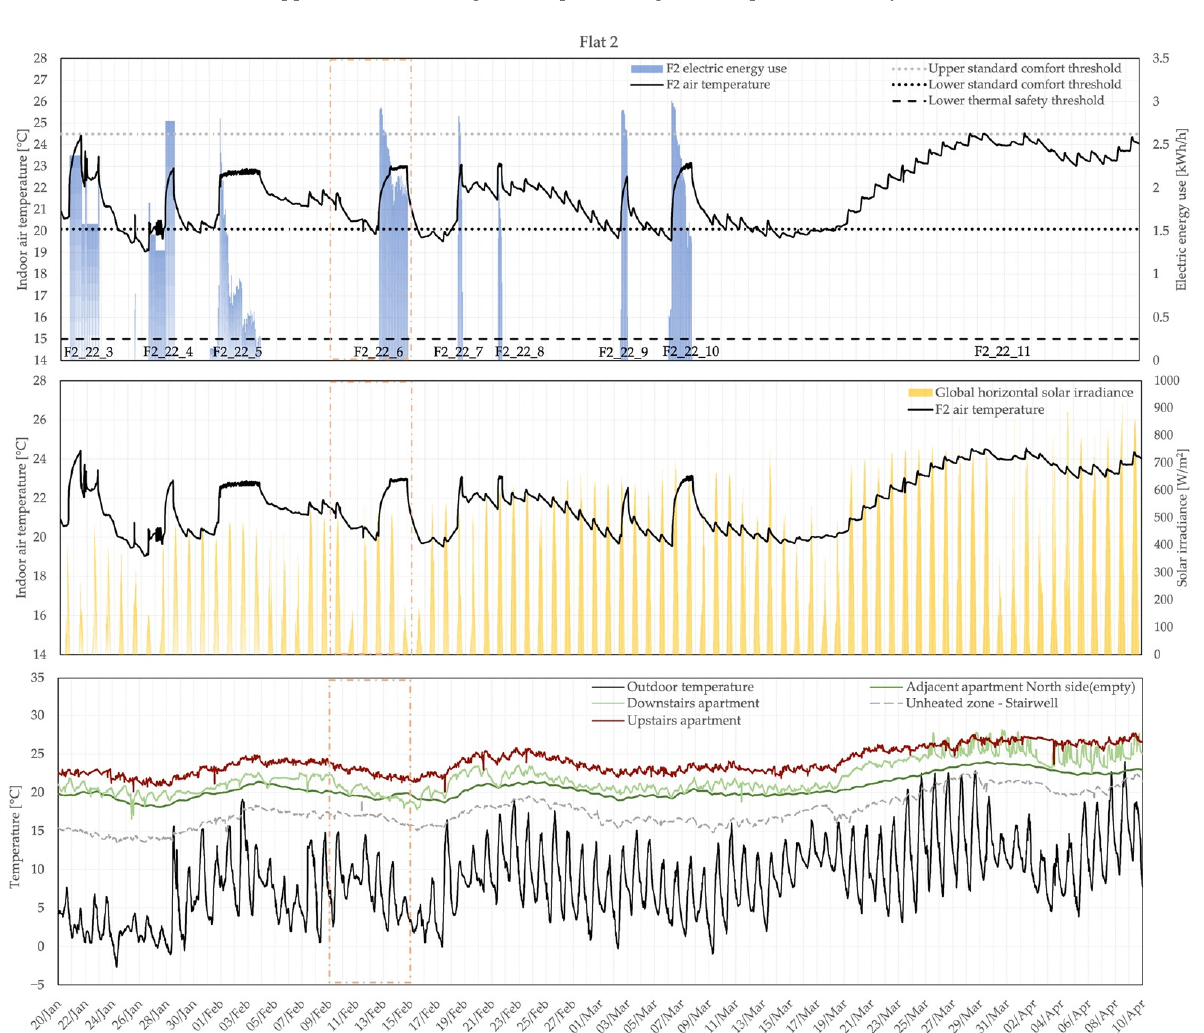
Figure 9. Representation of the indoor air temperature variation in the flat F2, located at the second floor and south-oriented during the tests performed from 20 January 2022 to 9 April 2022. The energy interruption occurred from 9 to 15 February in the entire building and is highlighted with orange, dashed lines.